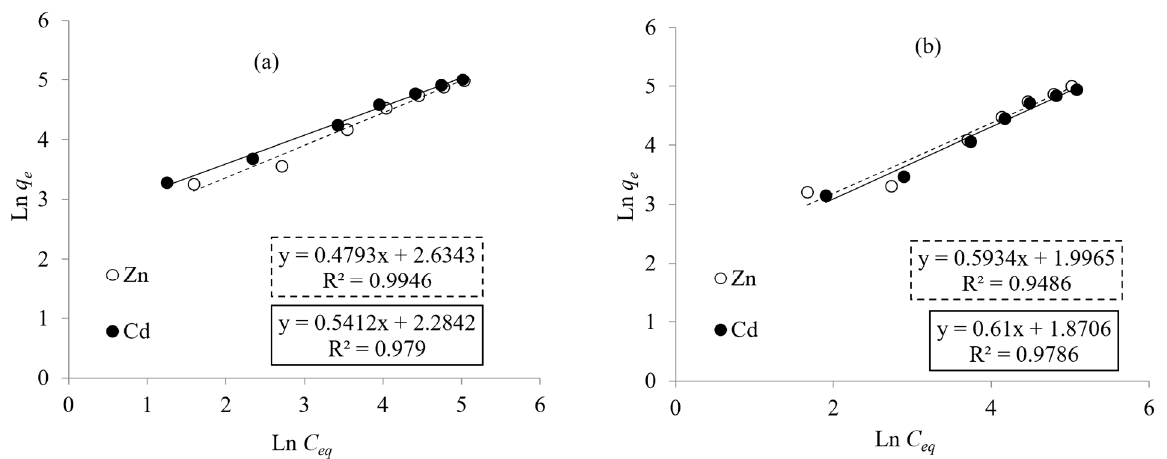
Figure 6. Linear form of Langmuir adsorption isotherms for adsorption of Zn 2+ and Cd 2+ by living